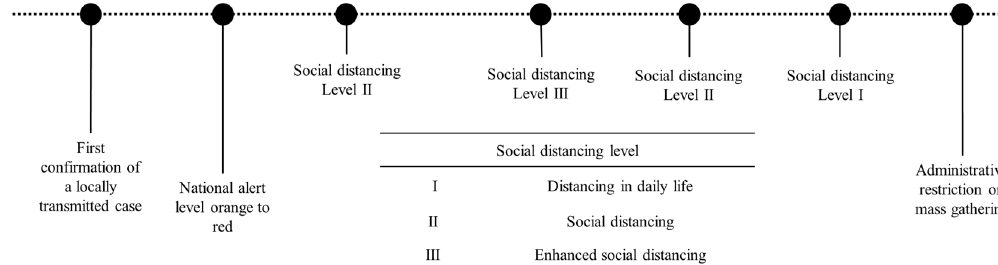
Figure 1. Timeline of significant events for COVID-19 local transmission. Table 1. Applied interventions according to social distancing levels.